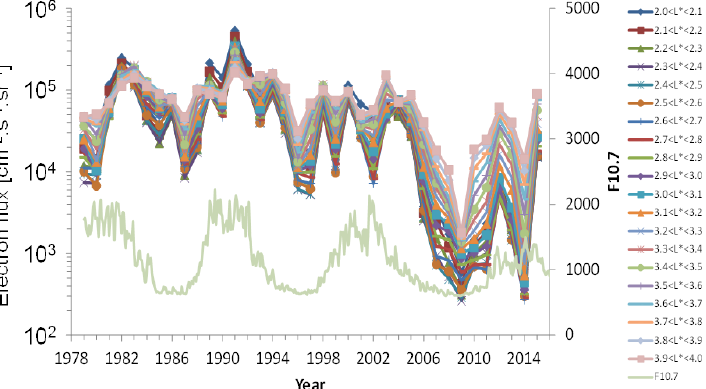
Figure 6. Electron >300keV fluxes vs. time (1978–2015) from all NOAA-POES data for each L ∗ interval defined in the SLOT model. F10.7 is also represented in